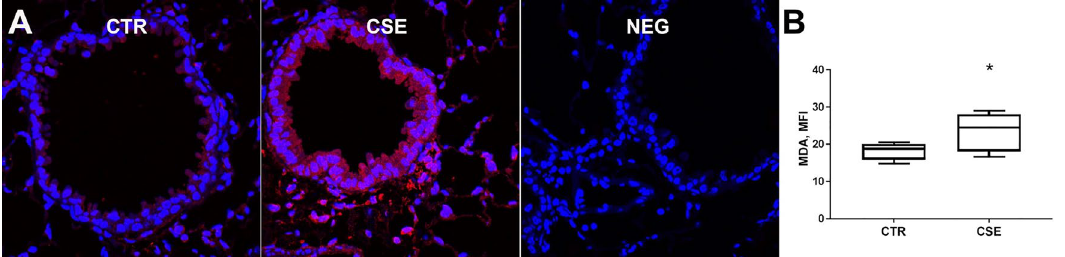
Figure 3. Cigarette smoke significantly increases malondialdehyde in mouse bronchial epithelia. ( A ) Representative immunofluorescence images of malondialdehyde staining in lung paraffin tissue blocks from control mice (CTR) and mice exposed to cigarette smoke for 6 weeks (CSE). ( B ) Box plot of malondialdehyde MFI in bronchial epithelia of CTR and CS-exposed mice (n = 6 per group). *p < 0.05 vs. controls via unpaired t-test.